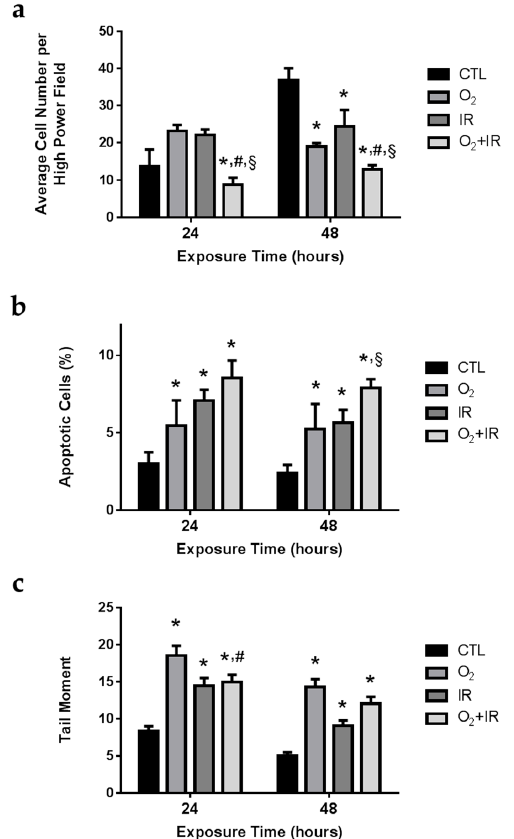
Figure 2. Determination of cell survival, apoptosis, and oxidative DNA damage in lung epithelial cells exposed to hyperoxia, radiation, and double-hit combination challenge. Non-tumorigenic murine alveolar type II epithelial cells (C10) were evaluated after 1 and 2 cycles of hyperoxia and radiation exposure for ( a ) cell survival using light microscopy (200×); ( b ) apoptotic bodies using fluorescent DAPI staining; and ( c ) DNA damage by comet assay analysis. Data are presented as mean ± SEM. * p < 0.05 for each exposure condition as it compares with the unexposed control (CTL) in the same respective time-group; # p < 0.05 for significant differences between O 2 -alone compared to O 2 + IR; § p < 0.05 for significant differences between IR-alone compared to O 2 + IR.